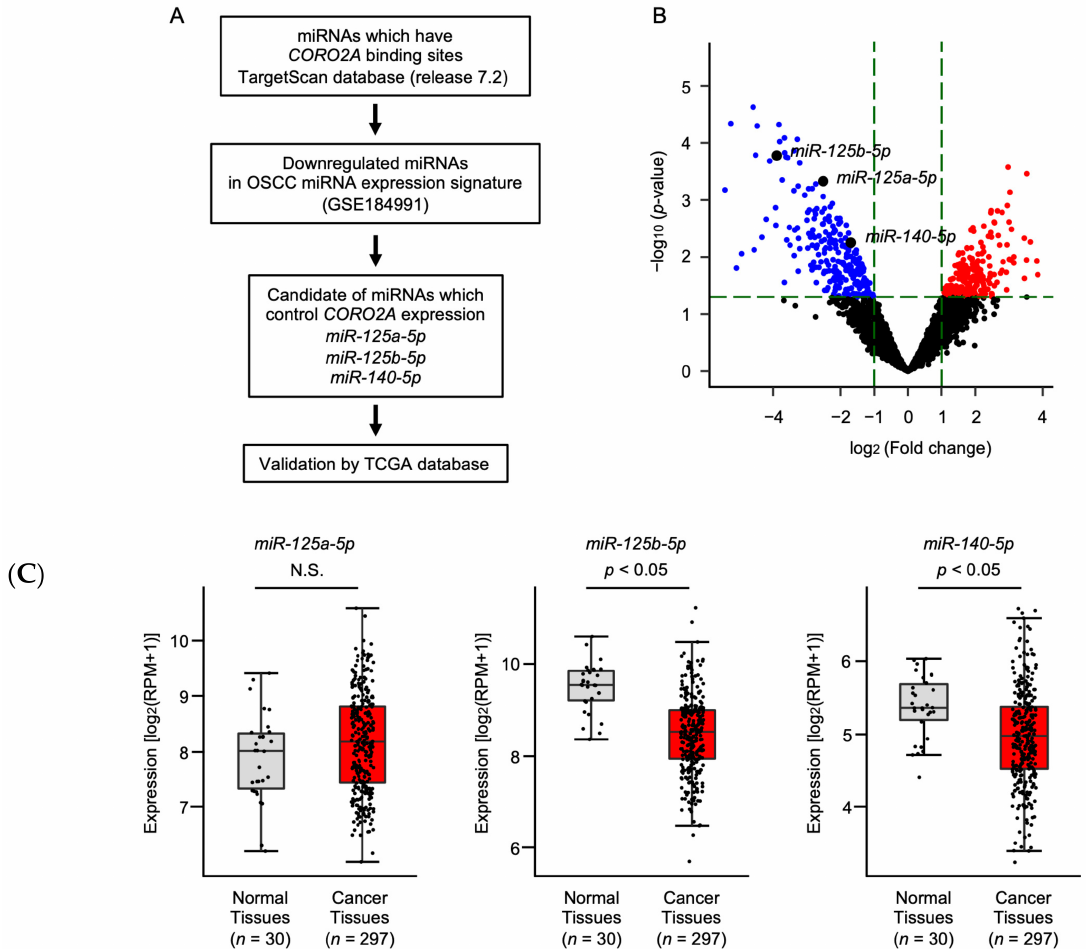
Figure 7. Selection of CORO2A controlled miRNAs in OSCC cells. To identify miRNAs controlling CORO2A expression in OSCC cells, we used the TargetScan database (release 7.2) and the miRNA expression signature of OSCC. ( A ) Flowchart of the strategy used to identify the candidate of CORO2A regulated miRNAs in OSCC cells. ( B ) Volcano plot of the miRNA expression signature determined through RNA sequencing. The log 2 fold change (FC) is plotted on the x-axis, and the log 10 ( p -value) is plotted on the y-axis. The blue points represent the downregulated miRNAs with an absolute log 2 FC < − 1.0 and p < 0.05. ( C ) The expression levels of miR-125a-5p , miR-125b-5p , and miR-140-5p evaluated in an HNSCC dataset from TCGA (N.S., not